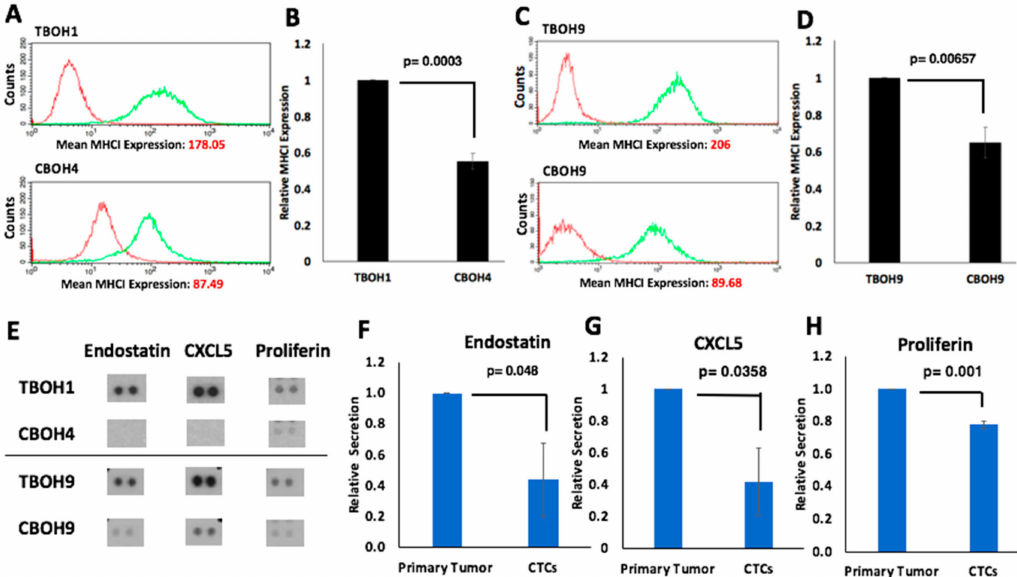
Figure 6. Immunomodulatory mechanisms of CTCs derived from a syngeneic mouse model of HCC. ( A–D ) Major histocompatibility complex class I (MHCI) expression was assessed using flow cytometry. CTCs have decreased MHCI cell surface protein expression in comparison to primary tumor-derived cell lines. Both isotype and MHCI antibodies were conjugated to fluorescein isothiocyanate (FITC). Isotype measuring background is shown in red. MHCI signal is shown in green; N = 5. ( E ) Analysis of 111 di ff erent cytokines secreted into cell media reveals consistent and significantly decreased secretion of endostatin, CXCL5, and proliferin in CTCs in comparison to primary tumor-derived cells; N = 2. ( F – H ) Endostatin, CXCL5, and proliferin signals from cytokine array were quantified. Data are presented as mean ± standard error of the mean